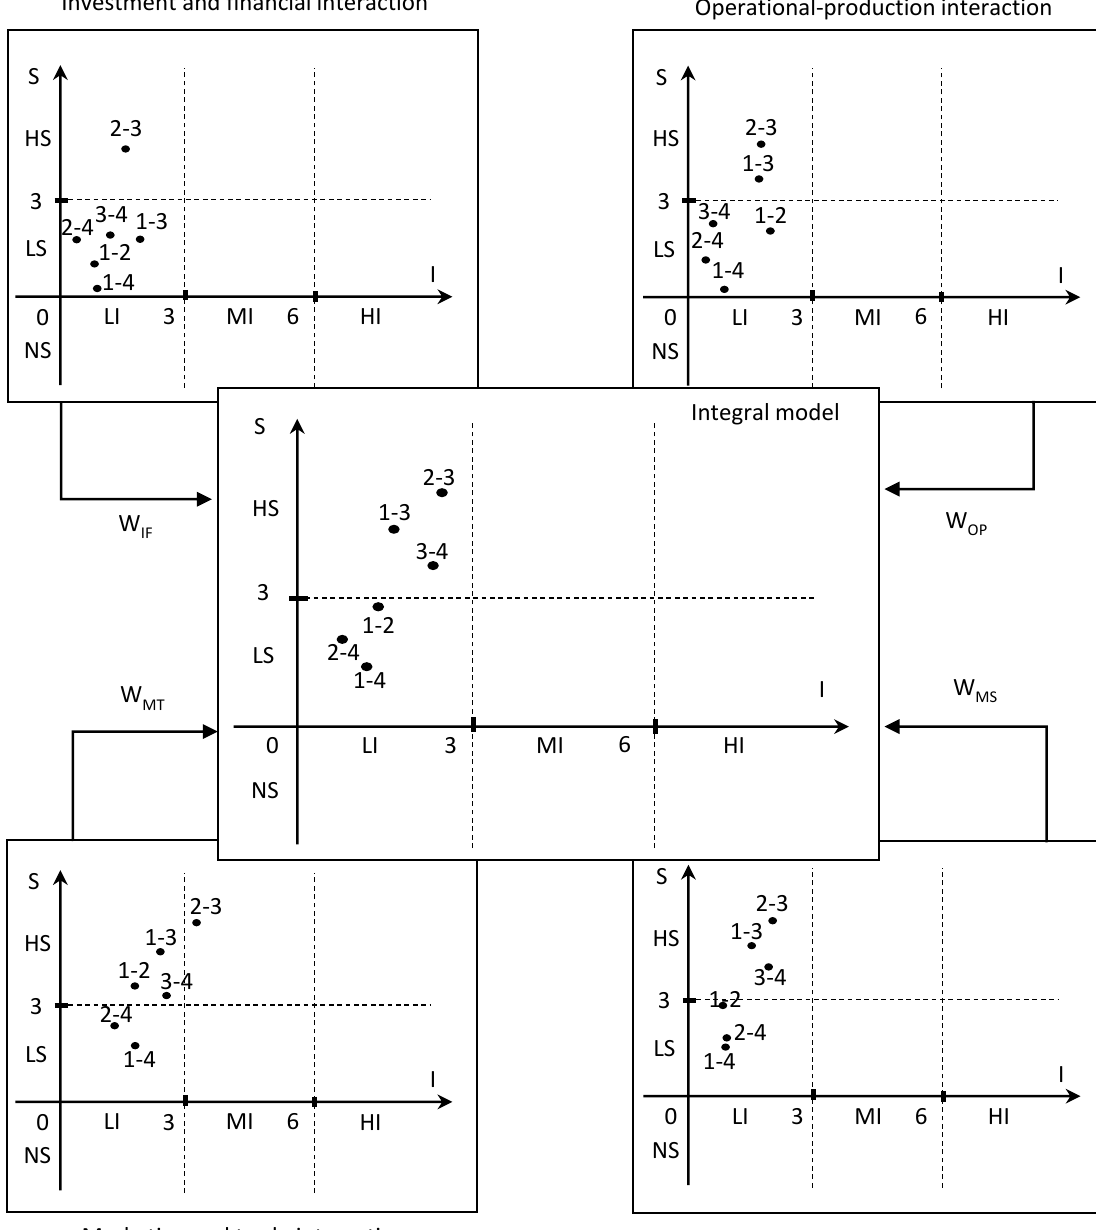
Figure 4. Integral matrix “interaction-synergism” for Ahromat